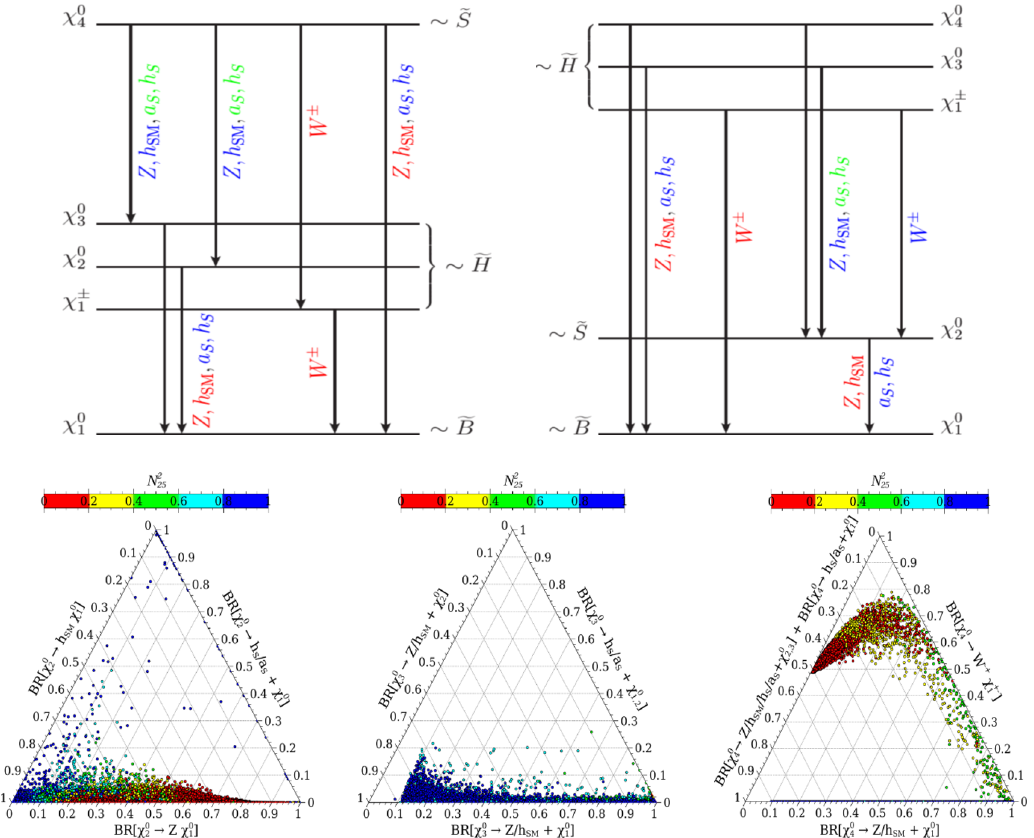
Figure 11 . Level diagrams showing two different neutralino hierarchies (top panel) with higgsino- like (singlino-like) NLSP on the left (right) and ternary scatter plots (bottom panel) presenting the branching ratios of the heavier neutralinos, χ 0 as functions of the singlino-content in the NLSP ( N 2 m ∼ M 2 = 2 . 5 TeV). See text for χ 0 5